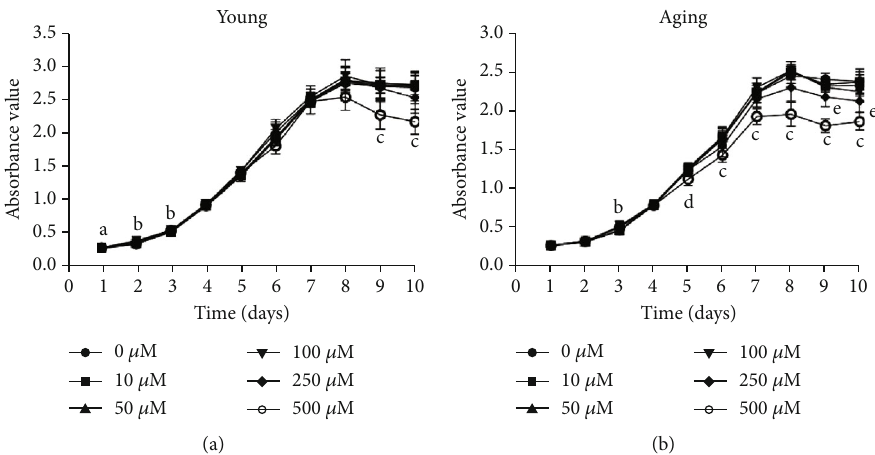
Figure 2: The in fl uence of metformin treatment on DPSC proliferation. (a) The in fl uence of metformin on young and (b) aging DPSC proliferation. Young and aging DPSCs were treated with 10, 50, 100, 250, and 500 μ M metformin for 1 to 10 days; cells with no drug added (0 μ M) served as controls. Cell proliferation was determined by CCK-8 assay. The absorbance value was read at a wavelength of 450nm. a, p < 0 : 01 , 100 μ M versus 0 μ M; b, p < 0 : 05 , 100 μ M versus 0 μ M; c, p < 0 : 01 , 500 μ M versus 0 μ M; d, p < 0 : 05 , 500 μ M versus 0 μ M; e, p < 0 : 01 , 250 μ M versus 0 μ M.